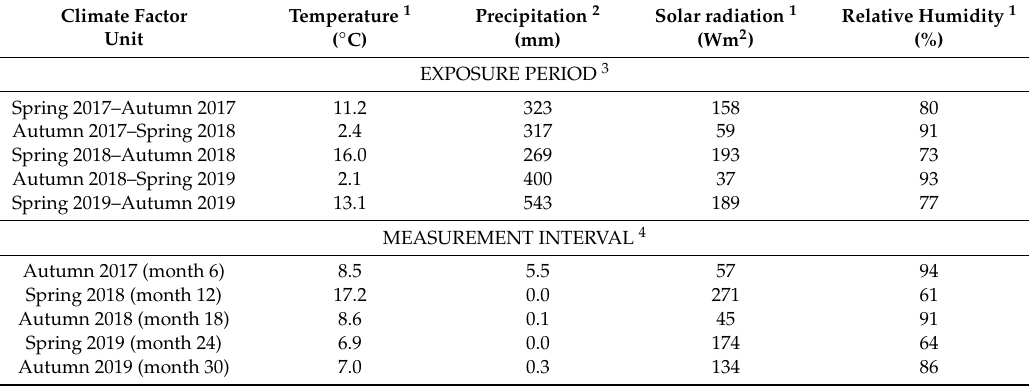
Figure 2. Control boards (light) and thermally modified (TM) boards (dark) placed on racks at the start of weathering: ( a ) overview, ( b ) detail of board positioned on its edge, and ( c ) detail of board positioned flat. Table 1. Weather conditions for exposure periods and at measurement intervals.